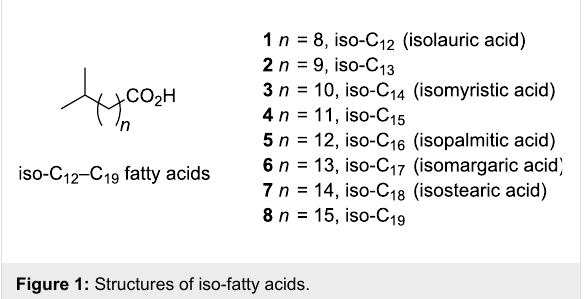
Figure 1: Structures of iso-fatty